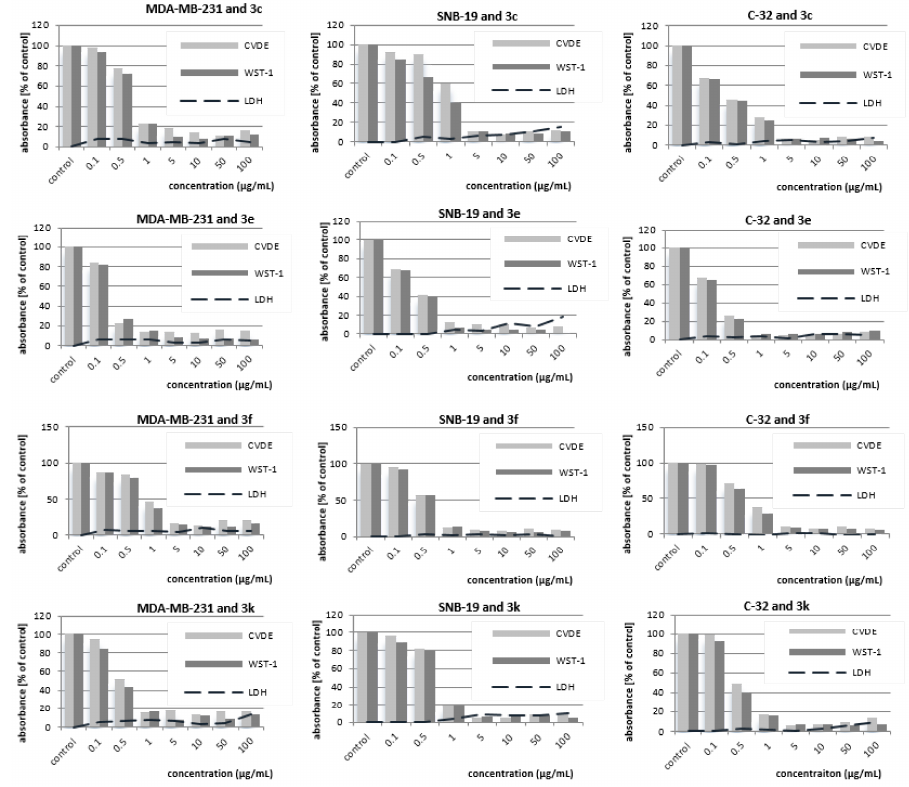
Figure 1. The effect of derivatives 3c , 3e , 3f , and 3k upon MDA-MB-231, SNB-19, and C-32 cancer cell lines (CVDE—cell number, WST-1—metabolic activity, LDH—number of dead cells in culture).